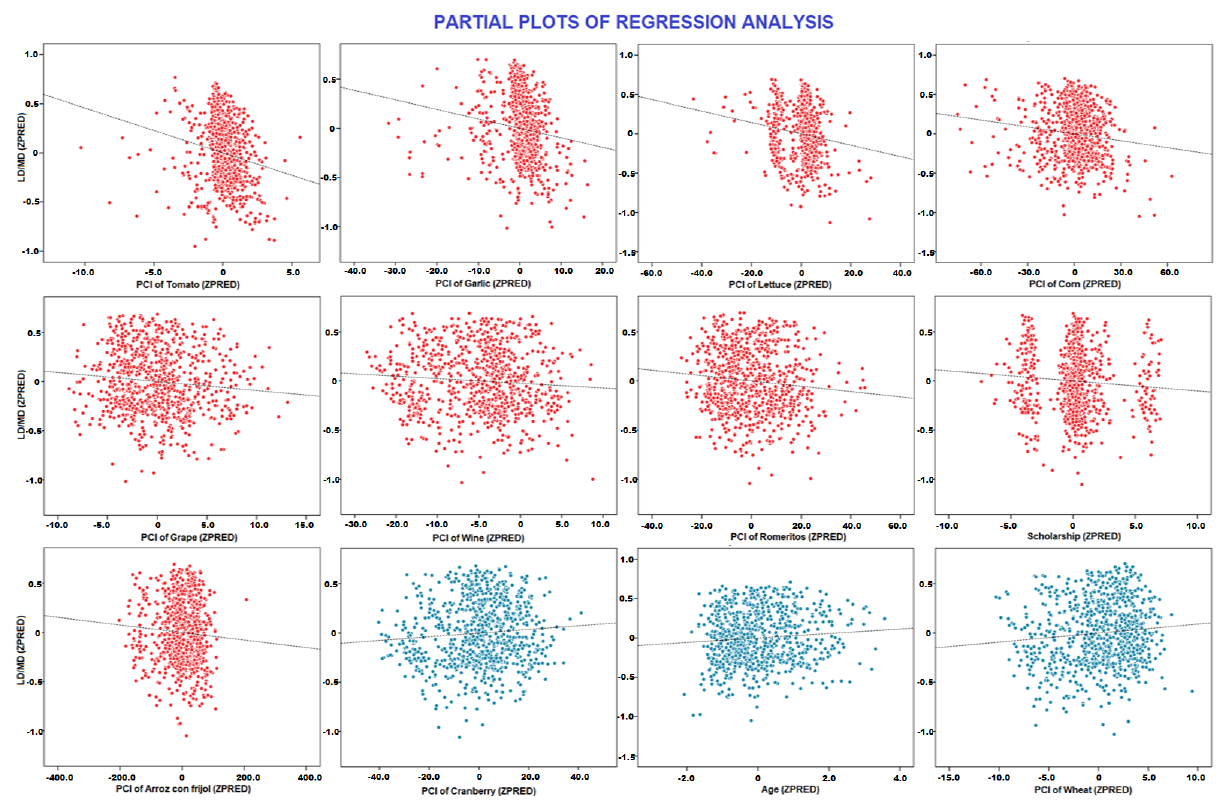
Figure 2. The scatter plots illustrate the relationship between LD and MD groups and predictor variables in the regression model. Negative associations are in red, and the positive ones are in blue.